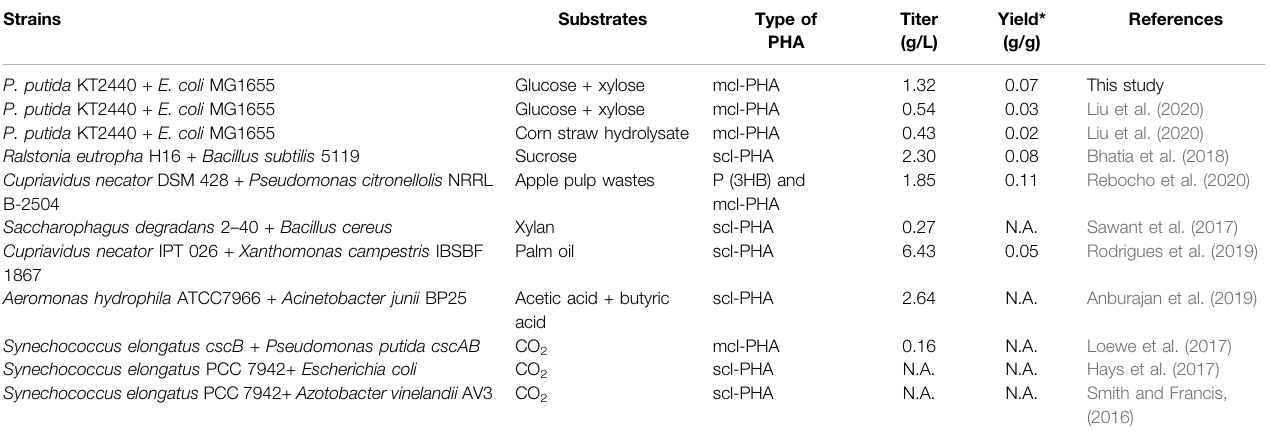
TABLE 1 | Research on arti fi cial consortia for PHA synthesis.